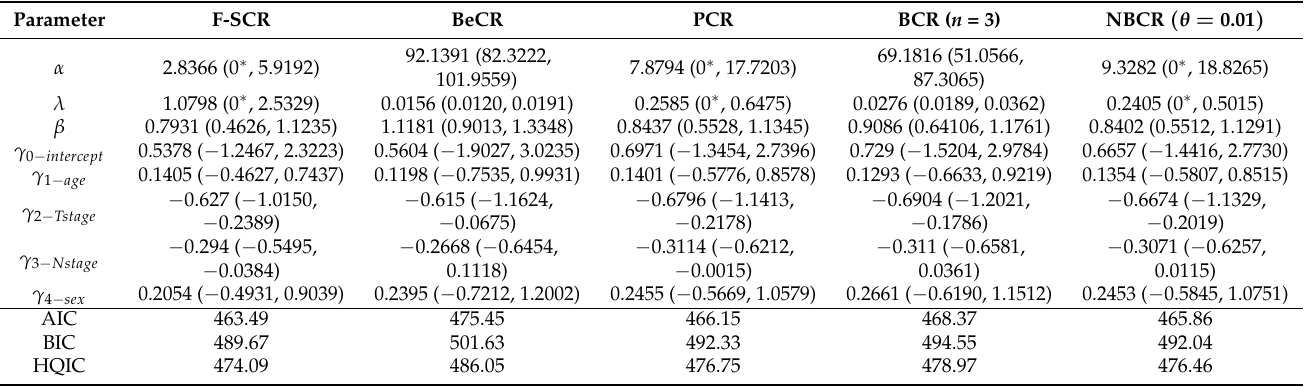
Table 5. ML estimators (95% confidence intervals) and information criteria for the oropharynx cancer data set based on GeTNH distribution.